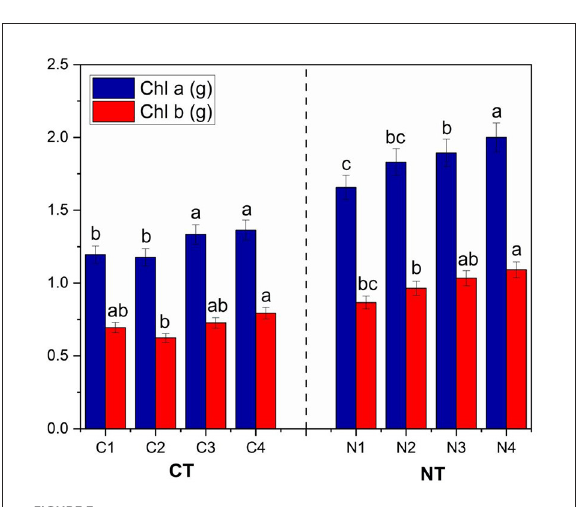
respectively, compared to control C1. In contrast,